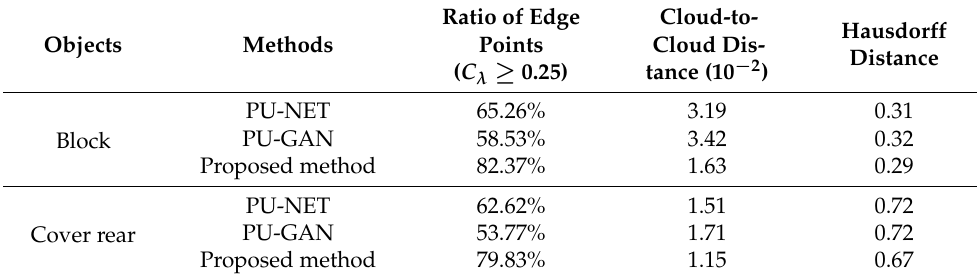
Table 2. Quantitative verification of the effectiveness of our method.